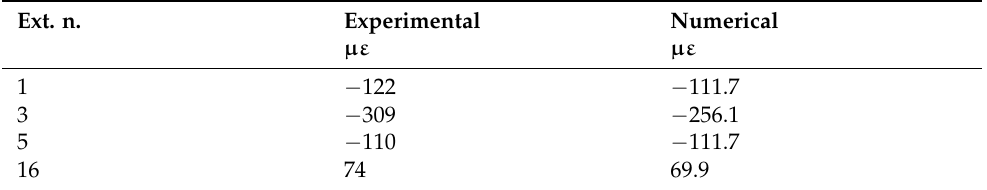
Table 5. Comparison between the experimental strain at the maximum load with the numerical strain for the distributed bending evaluated for a selected list of strain gauges. Ext. n. Experimental Numerical µε